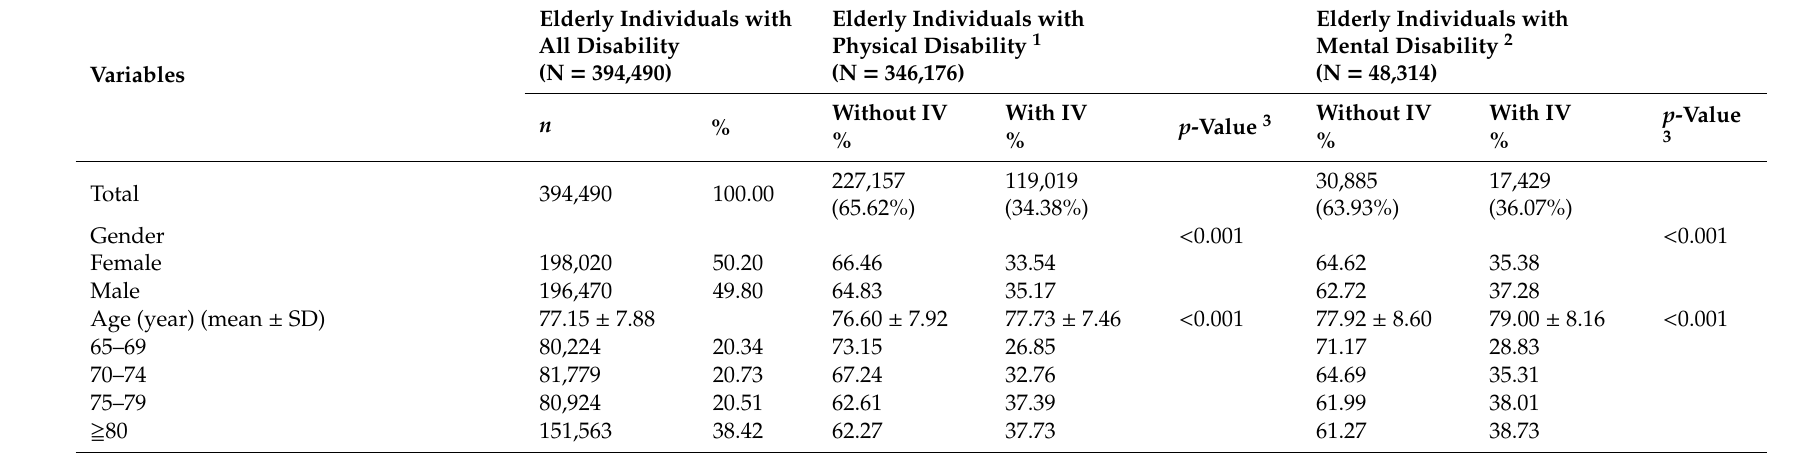
Table 2. Baseline characteristics of all disability elderly